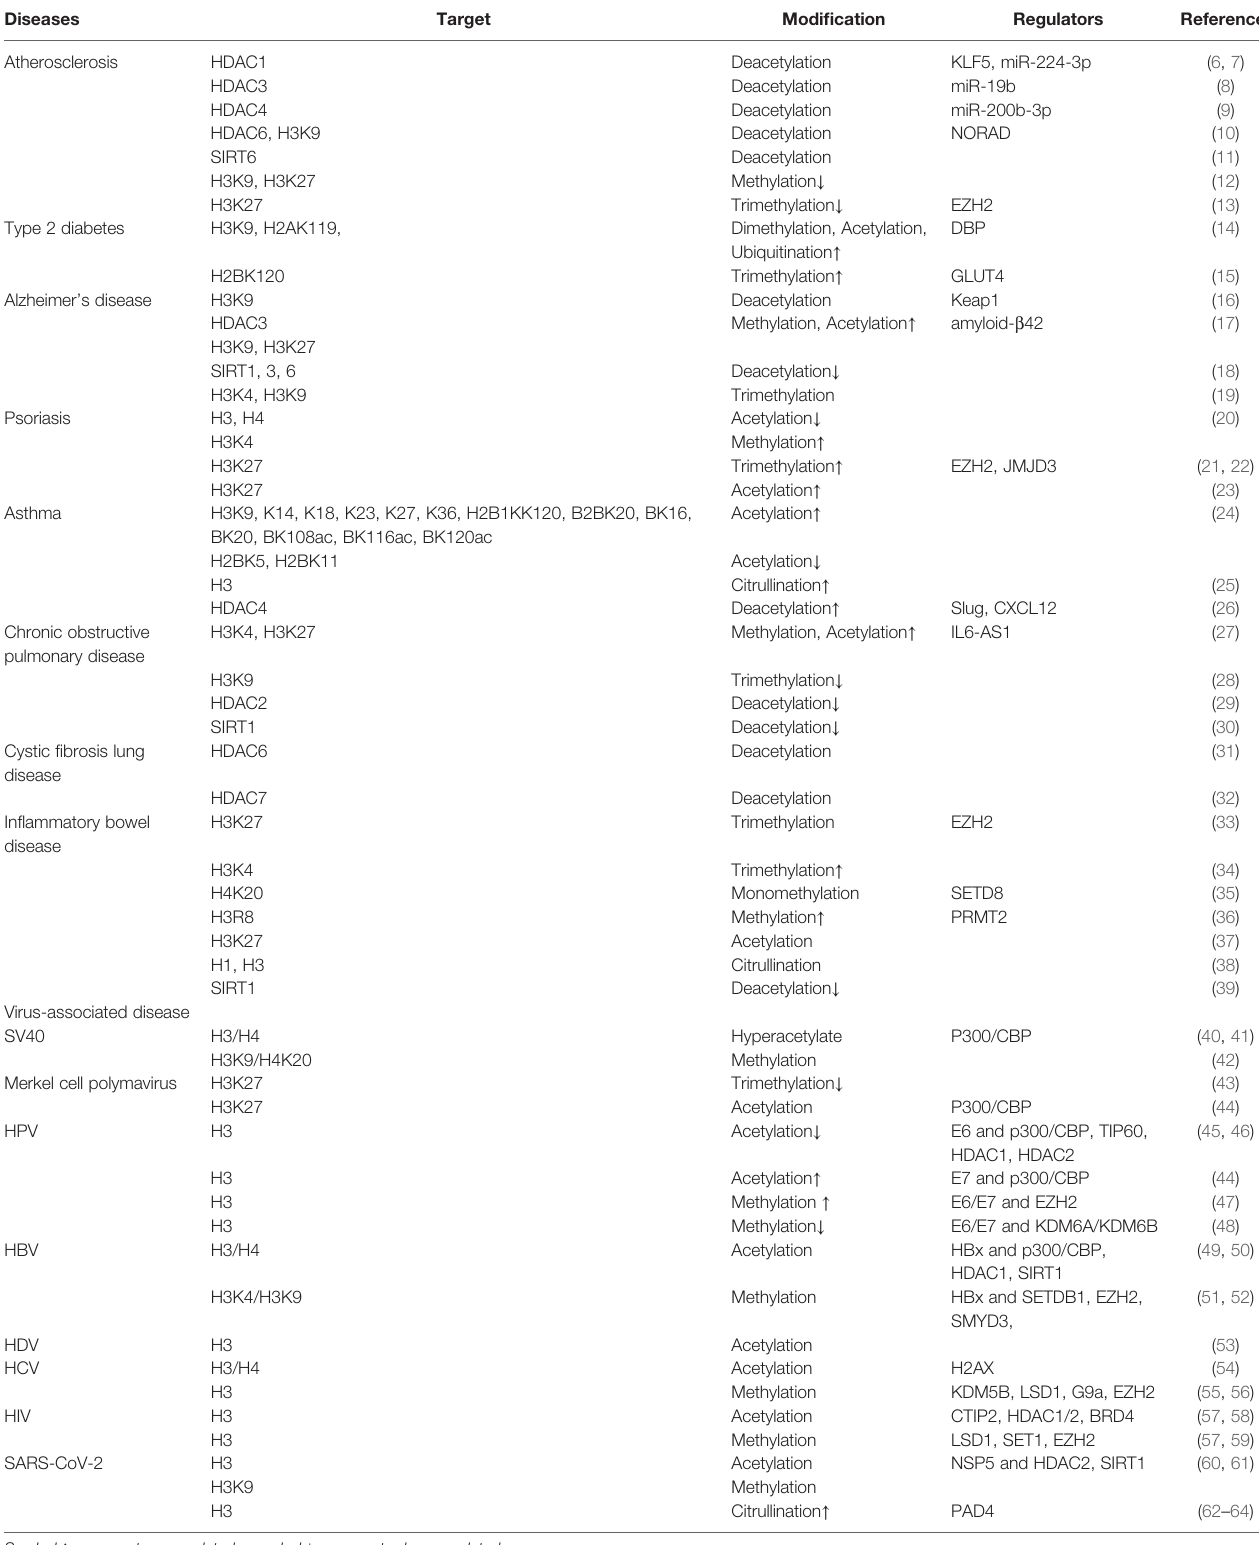
Symbol ↑ represents upregulated ， symbol ↓ represents